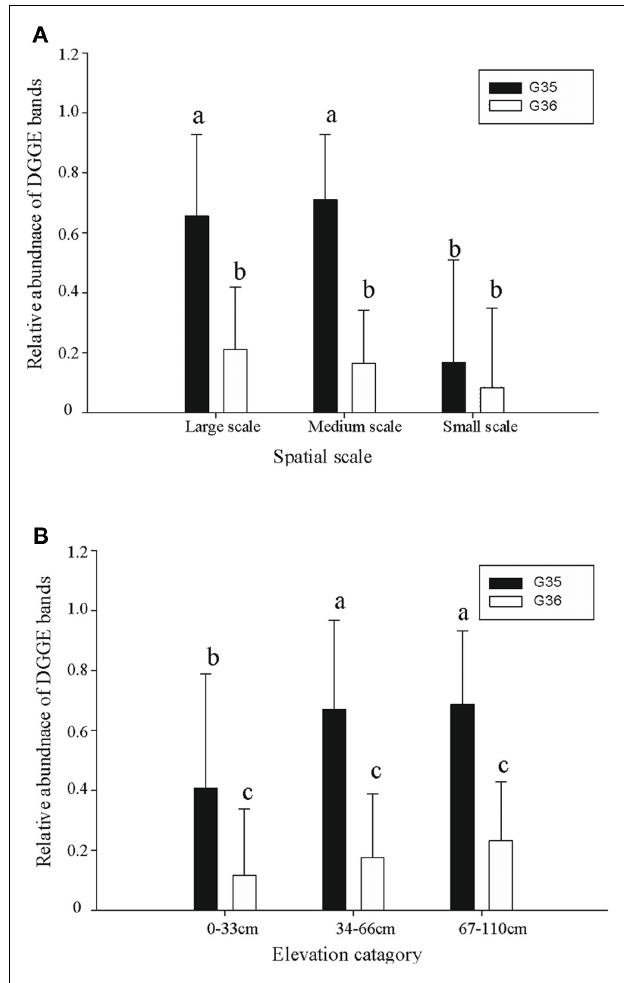
FIGURE 6 |The relative abundance of two dominant Ga-FeOB DGGE bands at different spatial scales (A) and elevation levels (B). Indicated are means ± SD. Different letters indicate significant differences ( p < 0.01) between bars. For factor “spatial” number of observations is n = 18 (Large), n = 22 (Medium), n = 14 (Small) while for factor “elevation” this is n = 25 (Large), n = 19 (Medium), n = 10